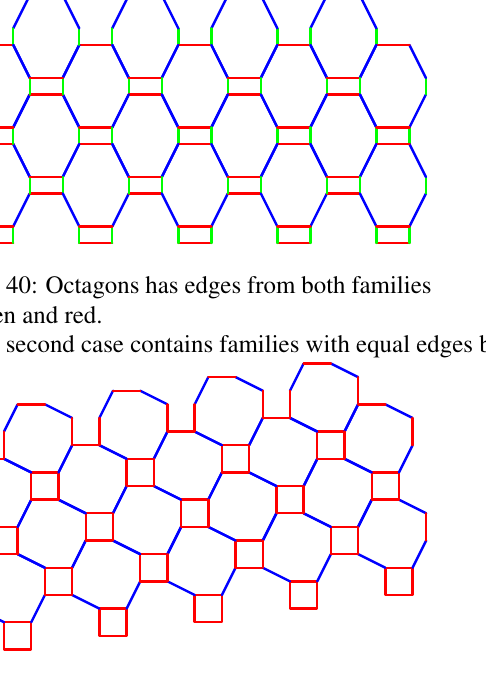
Fig. 42: Angles of both octagons are alternated.